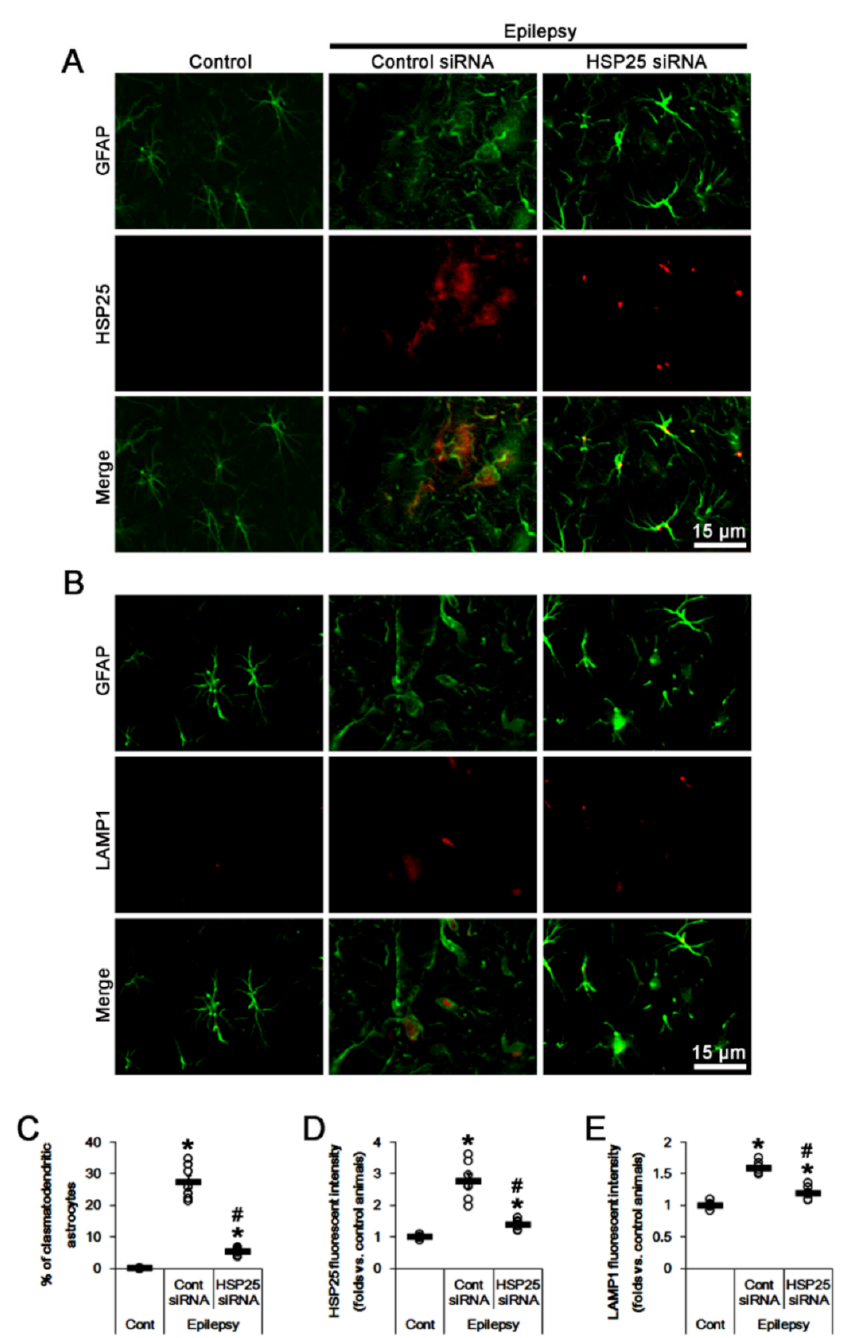
Figure 4. Effects of HSP25 knockdown on heat shock protein 25 (HSP25) and lysosomal-associated membrane protein 1 (LAMP1) expressions in CA1 astrocytes of control and epileptic rats. As com- pared to control animals (Cont), HSP25 and LAMP1 expressions are upregulated in CA1 astrocytes in epileptic rats. HSP25 siRNA reduces the increased HSP25 and LAMP1 expressions in CA1 astrocytes, as compared to control siRNA (cont siRNA). ( A , B ) Representative photos demonstrating astroglial HSP25 ( A ) and LAMP1 ( B ) expressions in CA1 astrocytes. ( C – E ) Quantifications of the fraction of clasmatodendritic astrocytes in total CA1 astrocytes ( C ), HSP25 expression ( D ) and LAMP1 fluores- cent intensity ( E ) in CA1 astrocytes. Open circles indicate each value. Horizontal bars indicate the mean value. Error bars indicate SEM (*, # p < 0.05 vs. control and control siRNA-treated epileptic rats, respectively; n = 7,